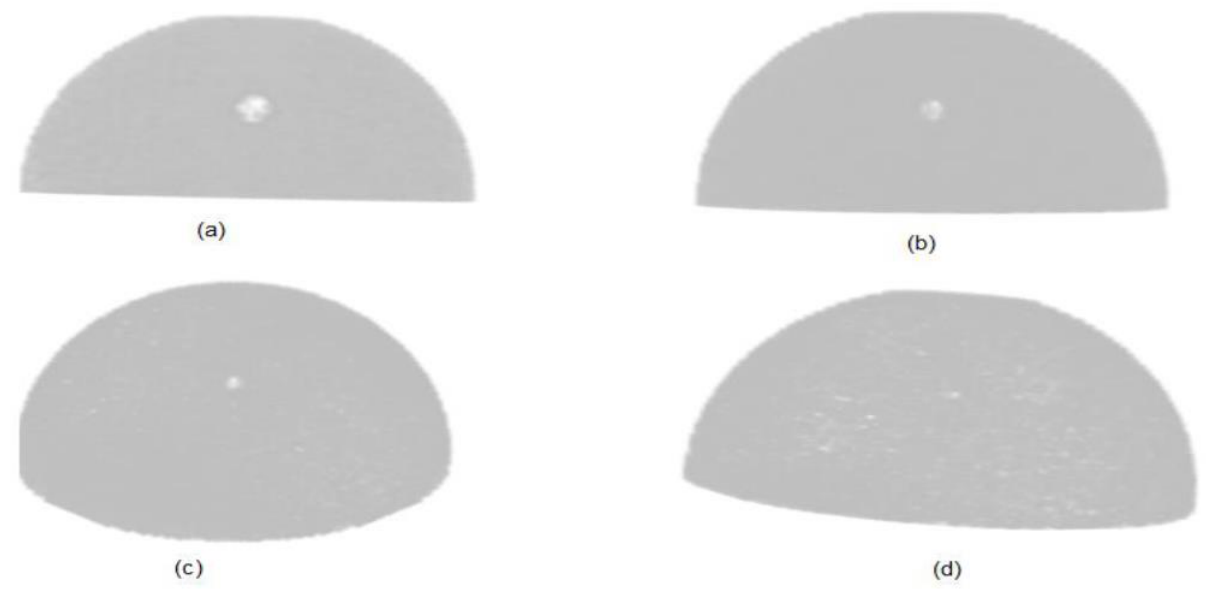
Figure 9. Breast phantom reconstructed images with ( a ) 8 mm tumor, ( b ) 6 mm tumor, ( c ) 4 mm tumor and ( d ) 3 mm tumor.